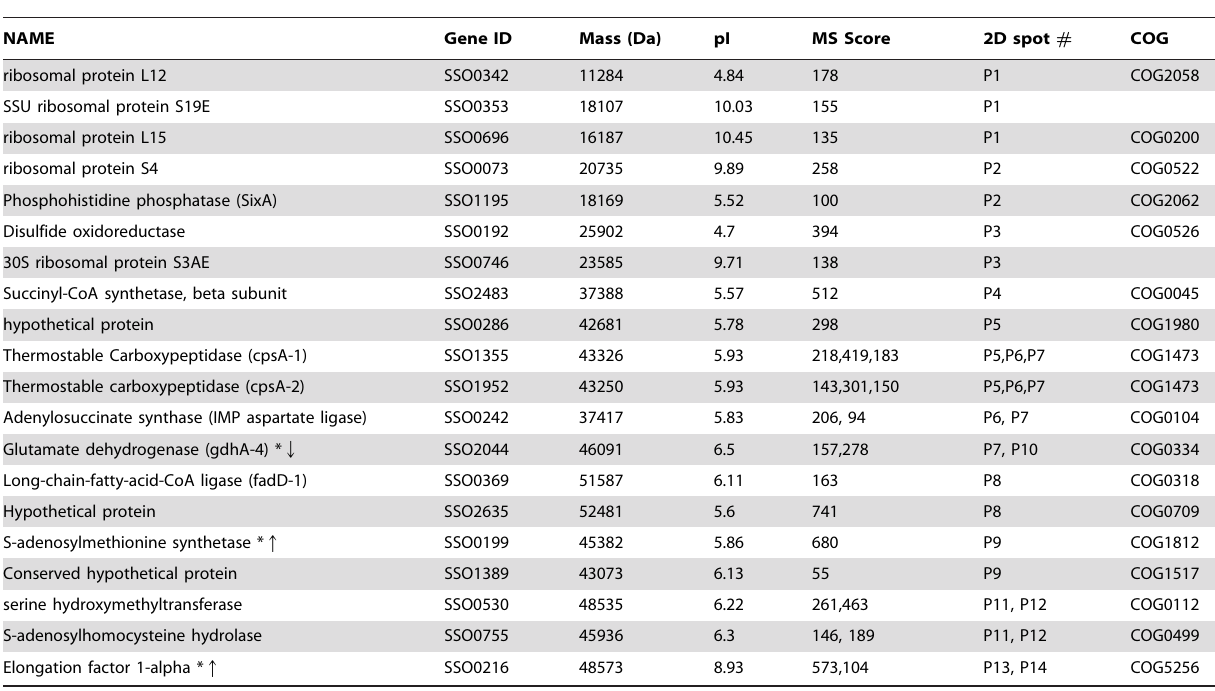
* Found among the regulated proteins, ? arrow indicates status of regulation